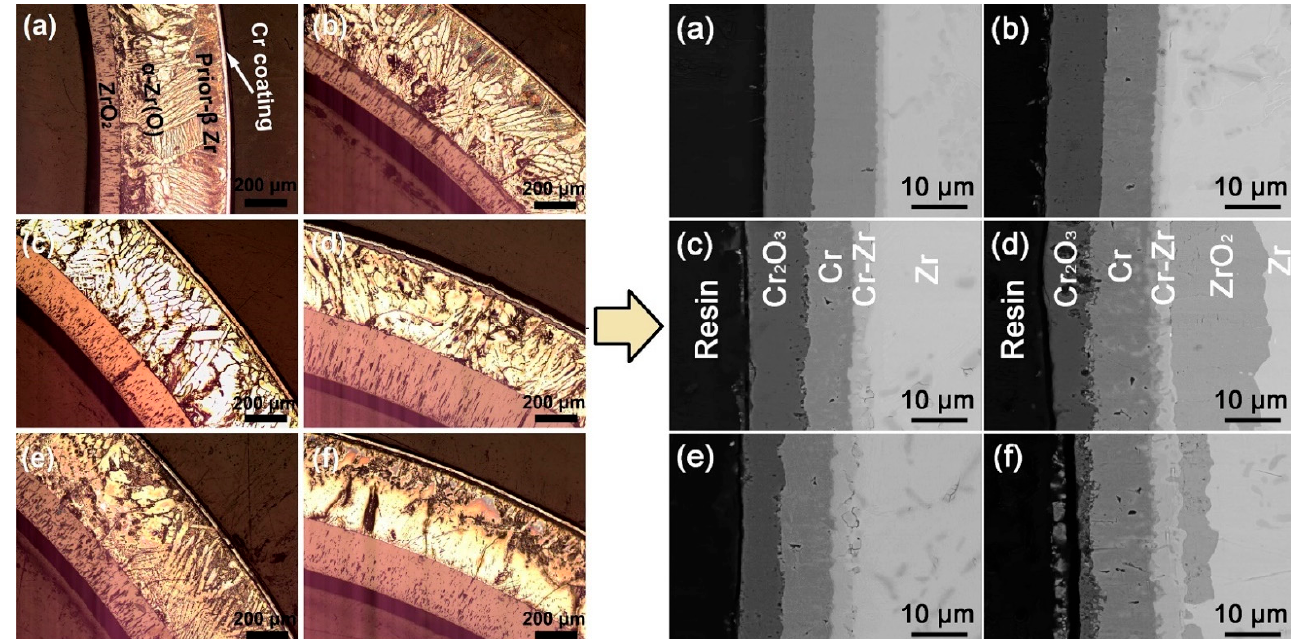
Figure 5. Optical and SEM images of Cr-coated zirconium alloy cladding after high-temperature steam oxidation at 1200 °C for 0.5 h ( a ), 1 h ( b ), 2 h ( c ), 4 h ( d ), and 1300 °C for 0.5 h ( e ) and 1 h ( f ). Reproduced from [95] .